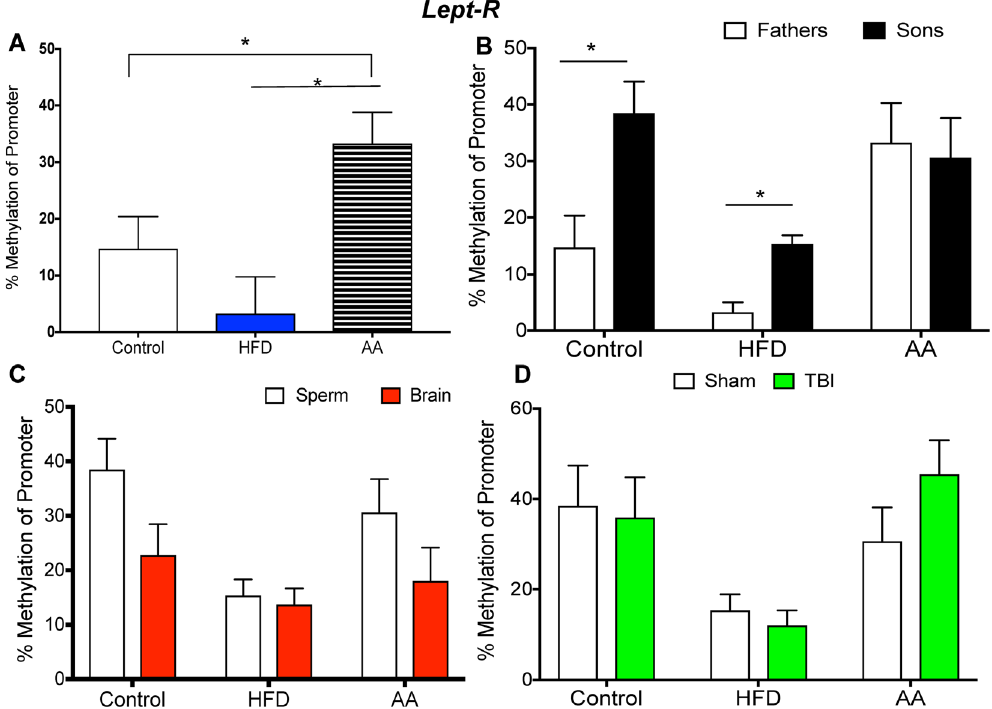
Figure 2. Illustrative demonstrations of Lept-R promoter methylation. One way ANOVAs were conducted and significant main effects are indicated ( * p < 0.05). ( A ) Average Lept-R promoter methylation in paternal sperm was significantly increased in AA sperm compared to control and HFD sperm ( p < 0.05). ( B ) Lept-R promoter methylation was significantly increased in sperm of sons of control and HFD fathers compared to paternal sperm ( p < 0.05). ( C ) There were no significant differences in Lept-R promoter methylation between sperm and brain of offspring ( p > 0.05). ( D ) There were no significant differences in Lept-R promoter methylation between sham and mTBI groups ( p >